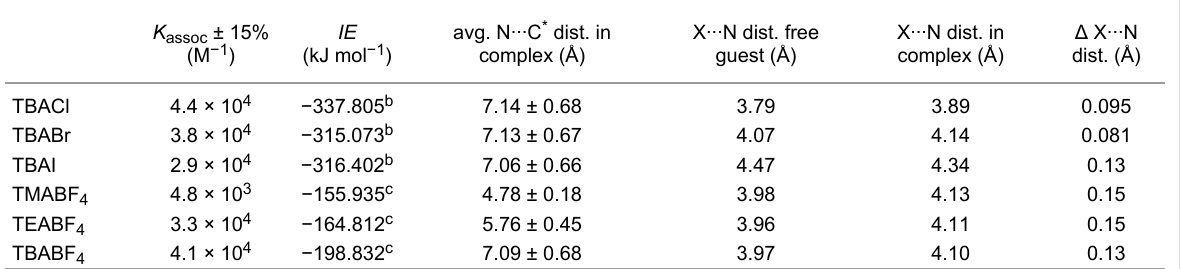
Table 1: Apparent experimentally-derived binding constants and DFT-computed interaction energies ( IE ) and selected interatomic distances derived from the geometry-optimized structures of the supramolecular complexes and their constituents.